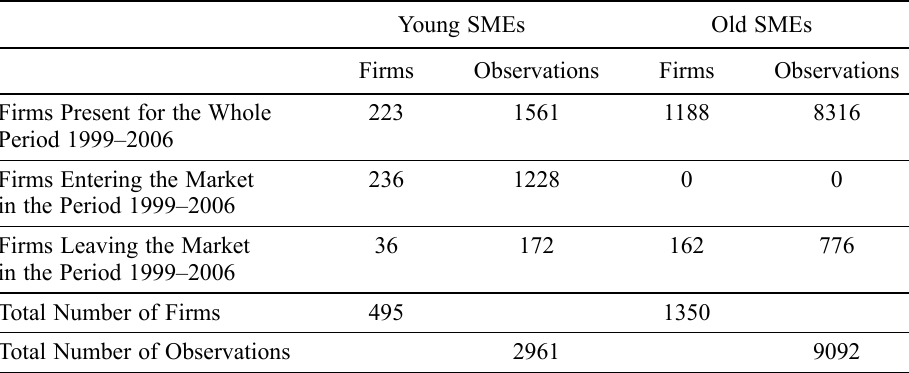
Table 1. Description of